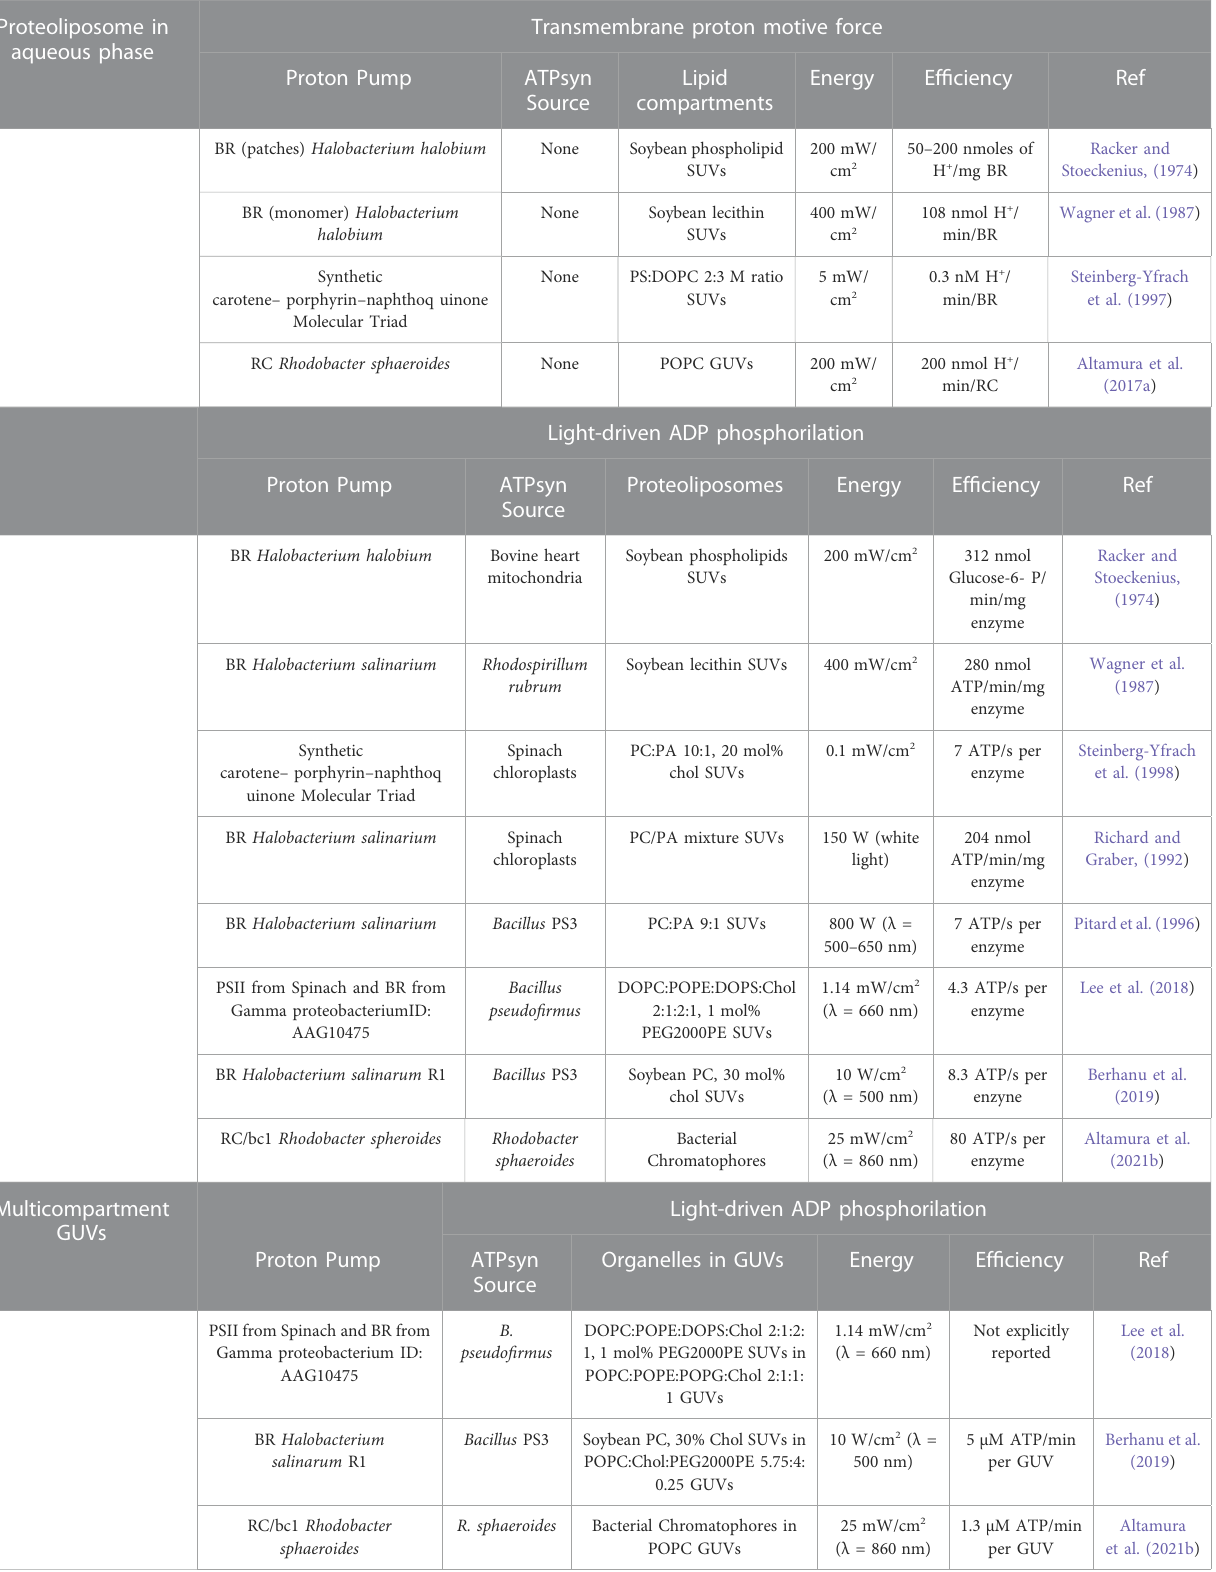
TABLE 1 Comparison of different photosynthetic lipid architectures for light-induced transmembrane pH gradient generation and ATP synthesis. Proteoliposome in aqueous